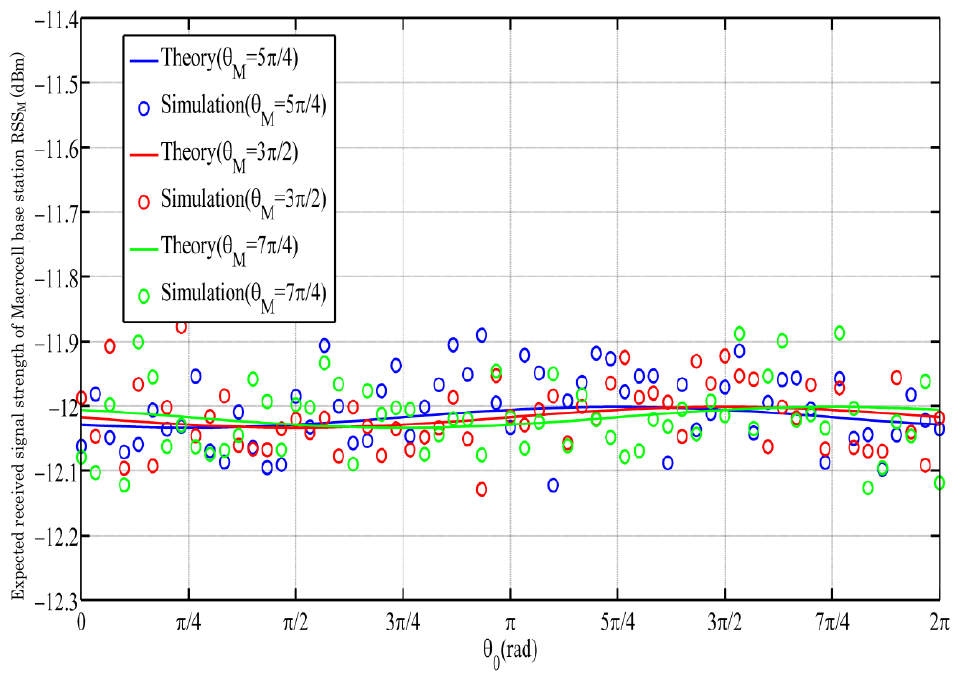
Figure 10. When r = 4.5 m/s, expected received signal strength of macrocell base station RSS M .